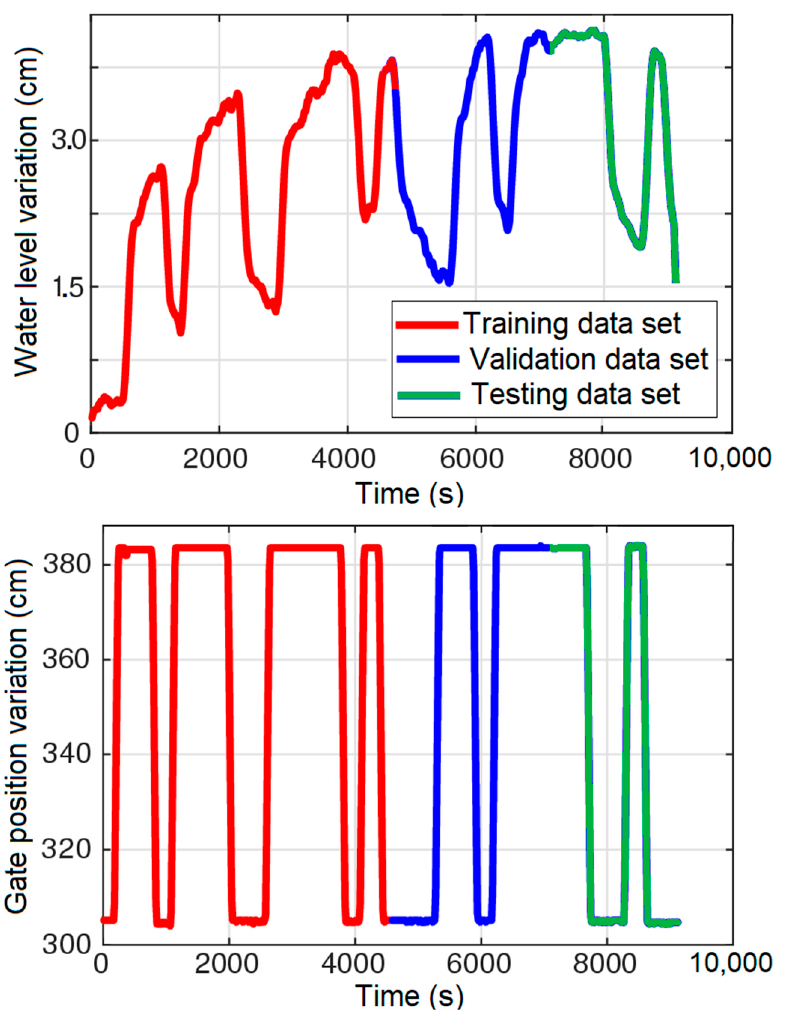
N Z of the irrigation canal pool studied. Figure 5. The obtained data set Z N of the irrigation canal pool